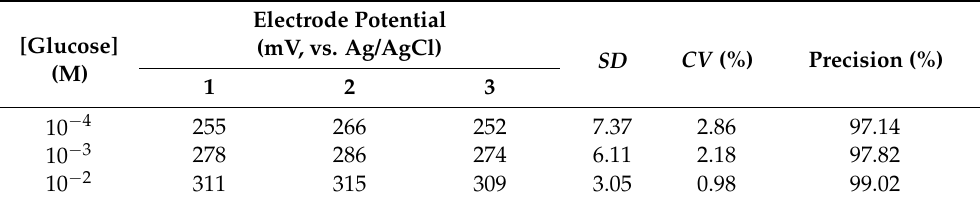
Table 5. Precision value when measuring glucose solution using E2.